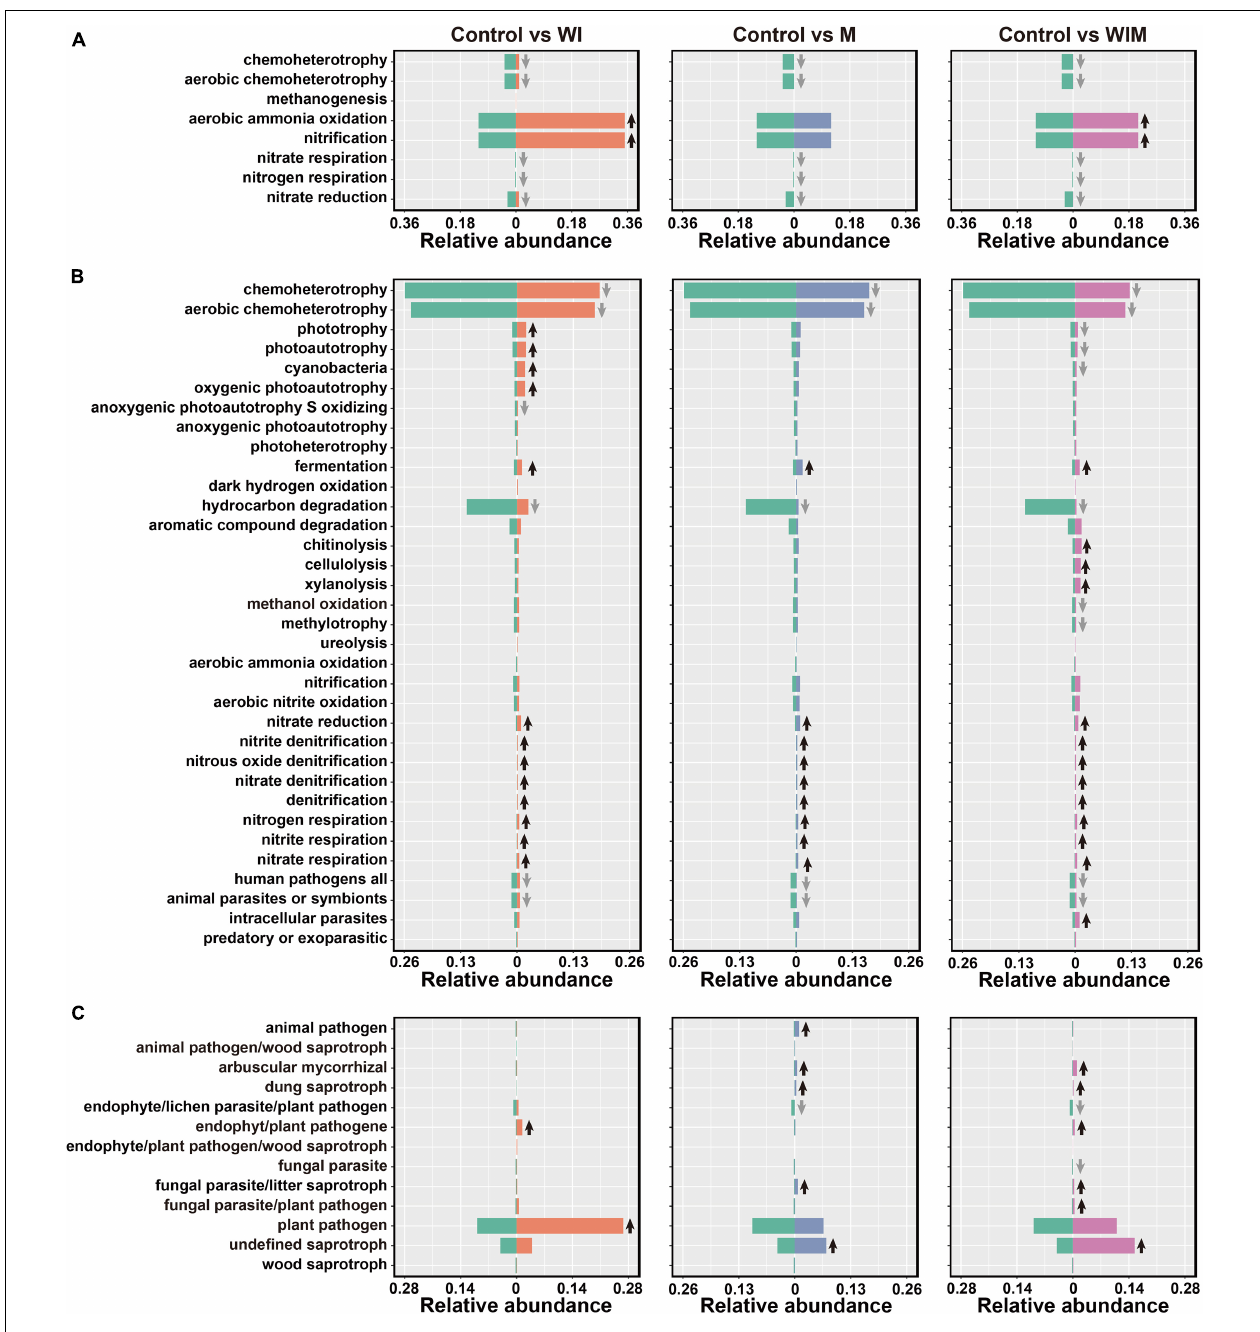
FIGURE 5 | Comparisons of functional community profiles of archaea (A) , bacteria (B) , and fungi (C) for different treatments using FAPROTAX (for the archaeal and bacterial communities) and FUNGuild (for the fungal community). Black up and gray down arrows indicate significantly higher and lower relative abundances compared with the Control, respectively ( P < 0.05, determined by Kruskal–Wallis rank sum test). WI, freezing saline water irrigation; M, plastic mulching; WIM, WI +